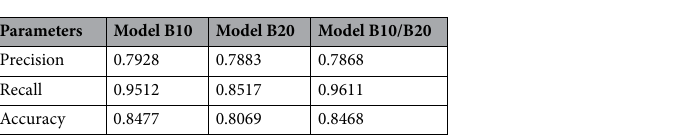
Table 4. The accuracy, precision, and recall values of each model.